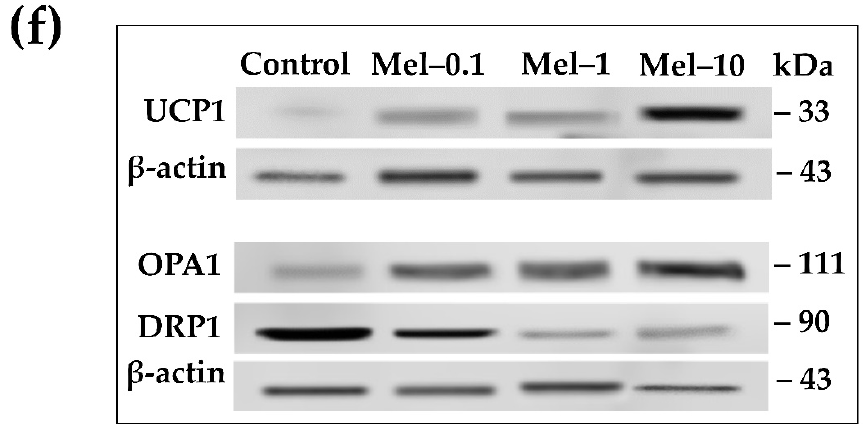
Figure 3. Dose-dependent effects of melatonin on hallmark thermogenic and mitochondrial dynamic markers in iBAT of Zücker diabetic fatty rats. ( a ) Representative microscopic immunofluorescent images of uncoupled protein 1 (UCP1) visualized with cyanine3 secondary antibody (original magnification × 200). ( b ) Immunofluorescence intensity quantification of UCP1. ( c – e ) Western blot densitometry quantification of UCP1, optic atrophy protein type 1 (OPA1), and dynamin-related protein1 (DRP1). ( f ) Representative Western blot images of UCP1, OPA1, and DRP1. Mel-0.1, Mel-1, and Mel-10: melatonin at a dose of 0.1, 1, and 10 mg/kg b.w, respectively. Values are means ± S.D ( n = 3) of UCP1 fluorescence intensity and ratios of specific protein levels to β -actin (loading protein). * p < 0.05, ** p < 0.01, *** p < 0.001 Mel-0.1, Mel-1 and Mel-10 vs. Control; # p < 0.05, ## p < 0.05 Mel-10 vs. Mel-0.1; § p < 0.05 Mel-10 vs. Mel-1; × p < 0.05 Mel-1 vs. Mel-0.1 (One-way ANOVA with